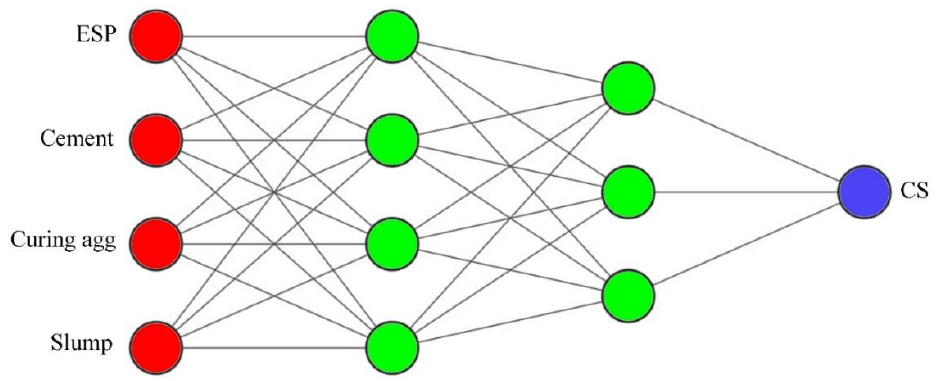
Figure 7. Proposed 4–4–3–1 topology of a feed-forward neural network.